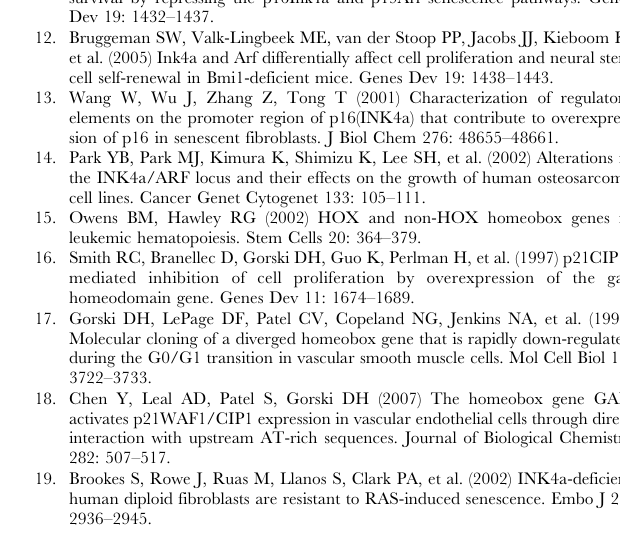
Found at: doi:10.1371/journal.pone.0005067.s002 (0.03 MB